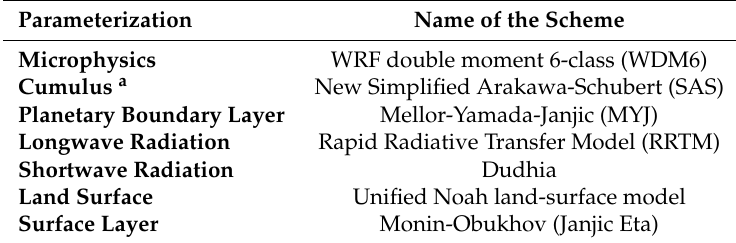
Table 1. Parameterization schemes used for the dynamical downscaling (DD) of the Community Climate System Model version 4 (CCSM4) Representative Concentration Pathway (RCP) 4.5 projection with the Weather Research and Forecasting (WRF)